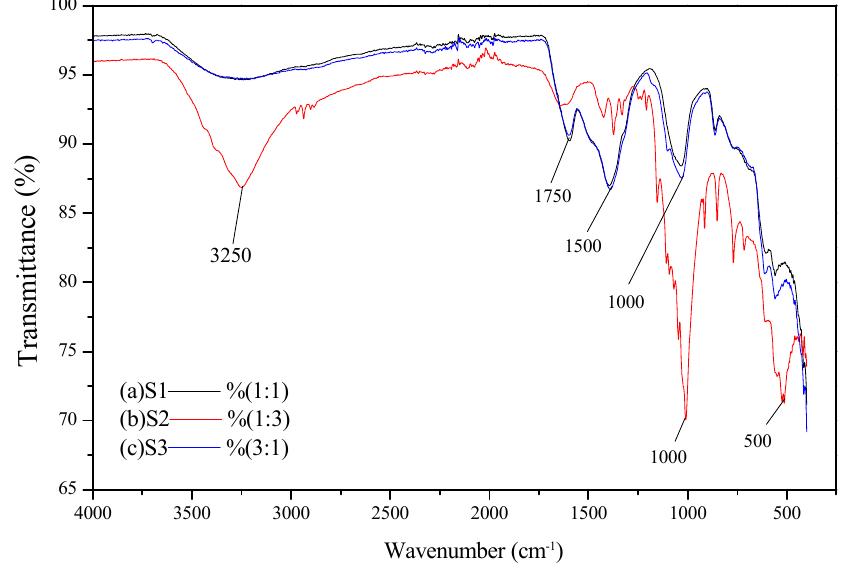
Figure 2. FT-IR spectra of samples ( a ) S1, ( b ) S2, and ( c ) S3. Figure 2. FT ‐ IR spectra of samples ( a ) S1, ( b ) S2, and (c) S3. Figure 2. FT ‐ IR spectra of samples ( a ) S1, ( b ) S2, and (c) S3.